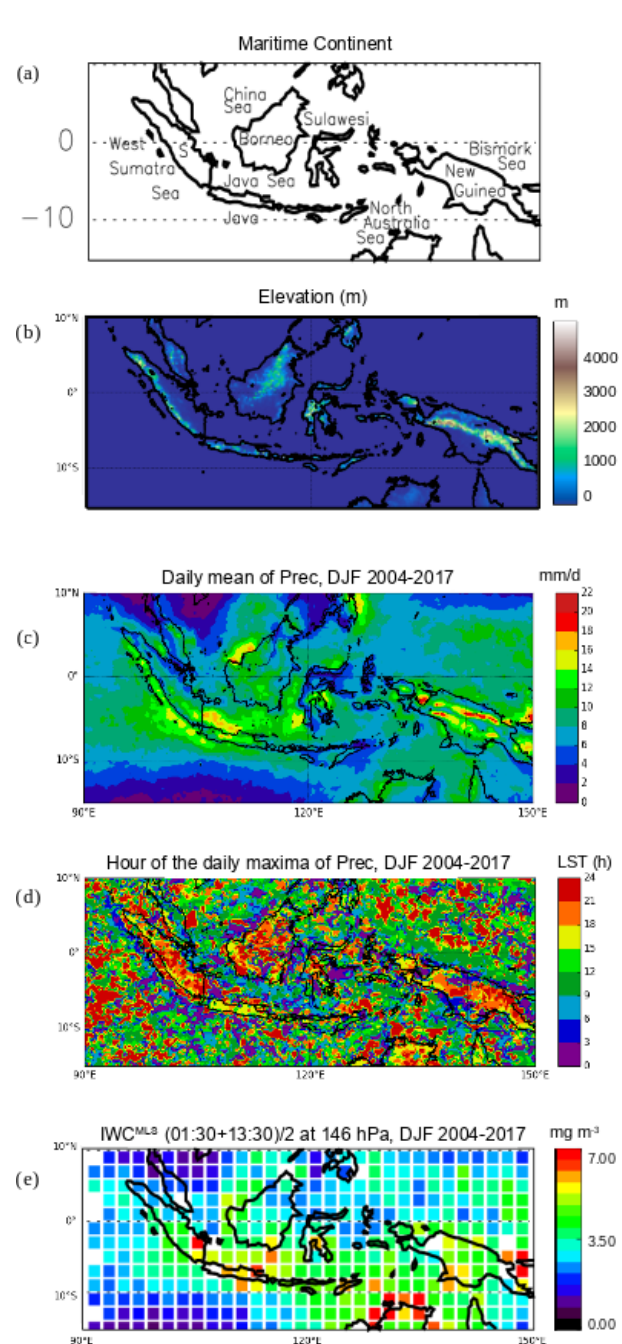
Figure 2. Main islands and seas of the MariCont (S is for Suma- tra) (a) . Elevation from Solar Radiation Data (SoDa) (b) . Daily mean of Prec obtained from TRMM analysis over the Maritime Continent, averaged over the period of DJF 2004–2017 (c) . Hour (local solar time (LST)) of the diurnal maxima of Prec over the MariCont (d) . Daily mean (01:30LT + 13:30LT) / 2 of IWC MLS at 146hPa from MLS over the MariCont averaged over the period of DJF 2004–2017 (e) . Observations are presented with a horizontal resolution of 0.25 ◦ × 0.25 ◦ (b, c, d) and 2 ◦ × 2 ◦ (e)